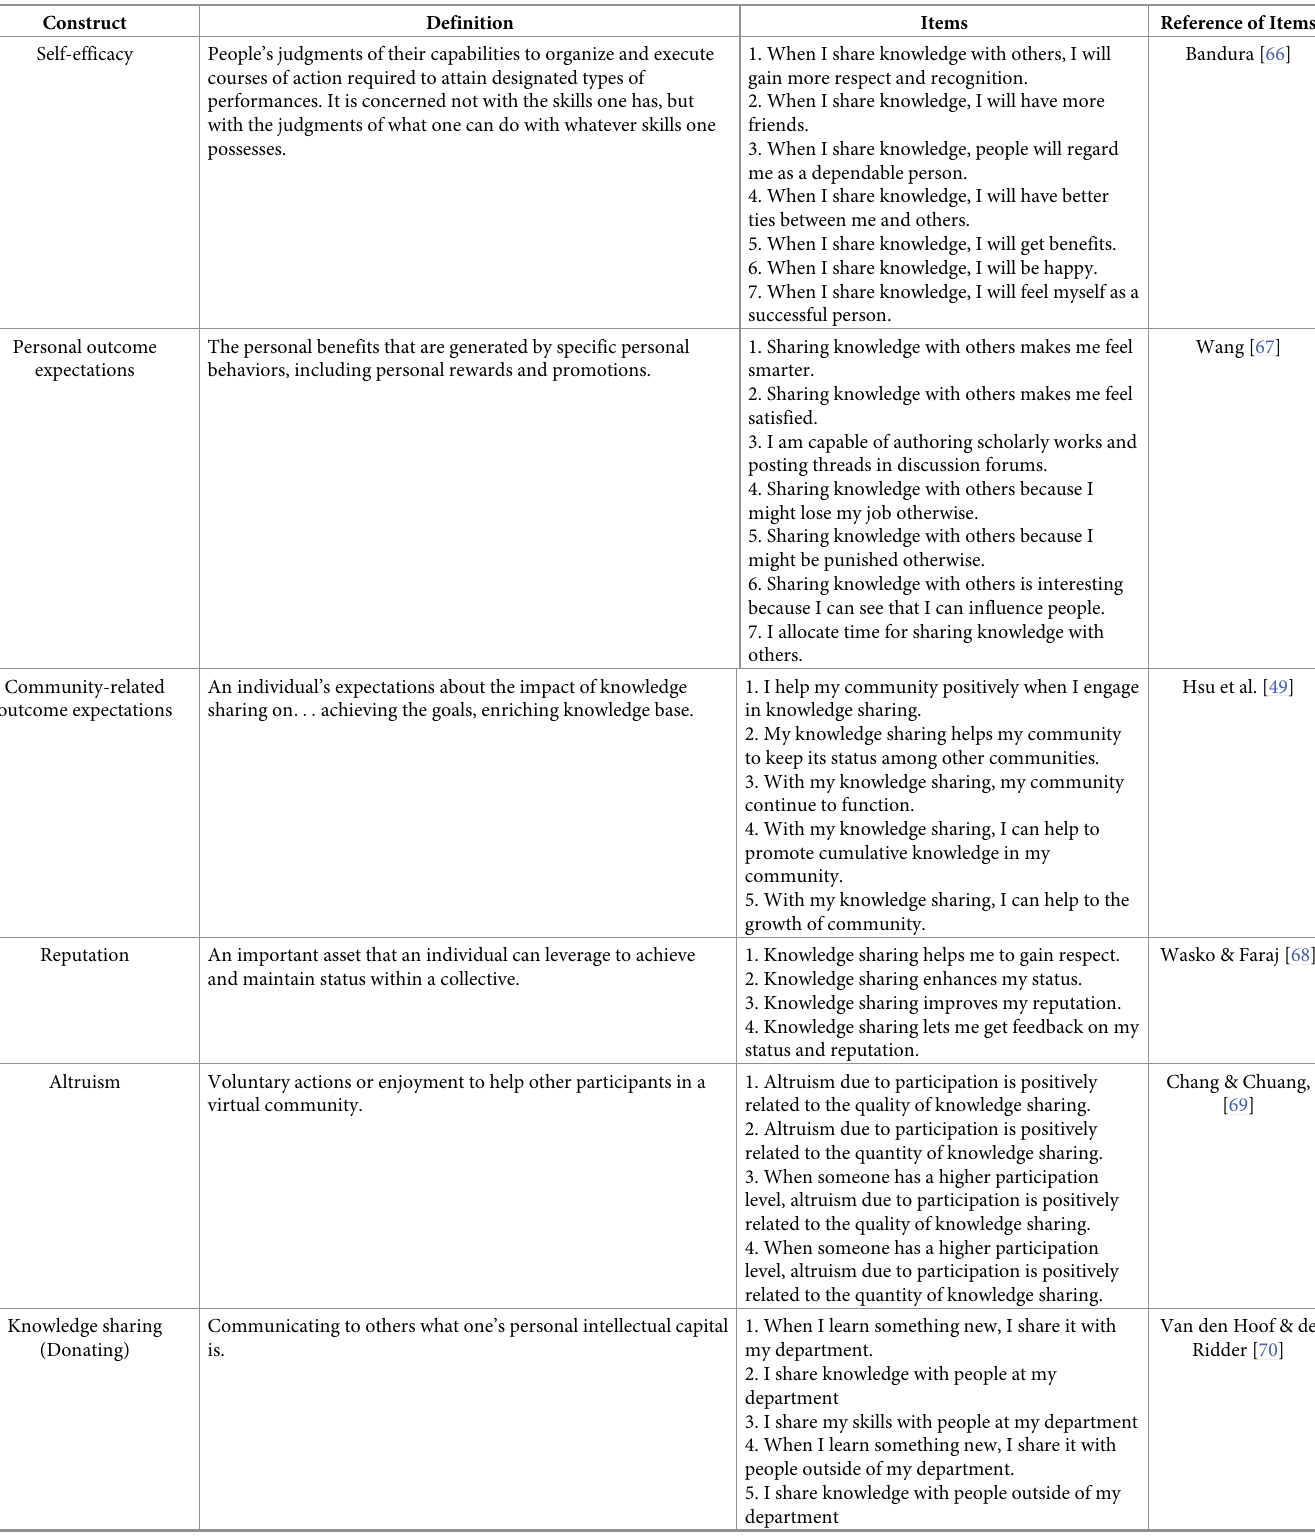
Table 1. Instrument